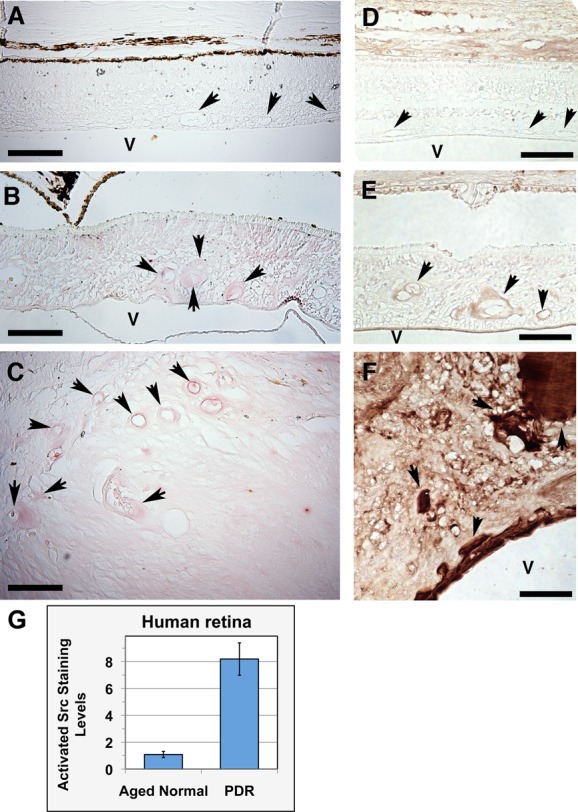
Levels of activated
Src family of kinases in retinal lesions of human neovascular retinopathy. (A-C) Immunohistochemical analysis of the levels of activated SFK (shown by red staining) revealing no staining in retinal blood vessels (arrow) of a normal aged human specimen (A), while intense staining in blood vessels (arrow) of retinal lesions of human neovascular retinopathy specimens (PDR) (B,C). Images are oriented with the vitreous cavity (v) of the eye at the bottom of the panels although the fibrovascular lesion in the neovascular retinopathy image in C takes up the whole panel. (D-F) Immunohistochemical analysis of the distribution Albumin (shown by brown staining) of the specimens respectively shown in A through C revealing some staining in retinal blood vessels (arrow) but not in the neural retina of a normal aged human specimen (D), while intense staining in blood vessels (arrow) and neural retina of fibrovascular lesions of human neovascular retinopathy specimens (PDR) (E,F). A-F: 200×, scale bar=100 µm, representative images shown. (G) Levels of activated SFK in retinal blood vessels are expressed as fold of staining over a reference normal aged specimen. Values for age-matched normal are significantly different than the neovascular values (P=0.000007). Data is expressed as mean±s.e.m. of 3 duplicate experiments in PDR group and 6 duplicates in the aged normal group.